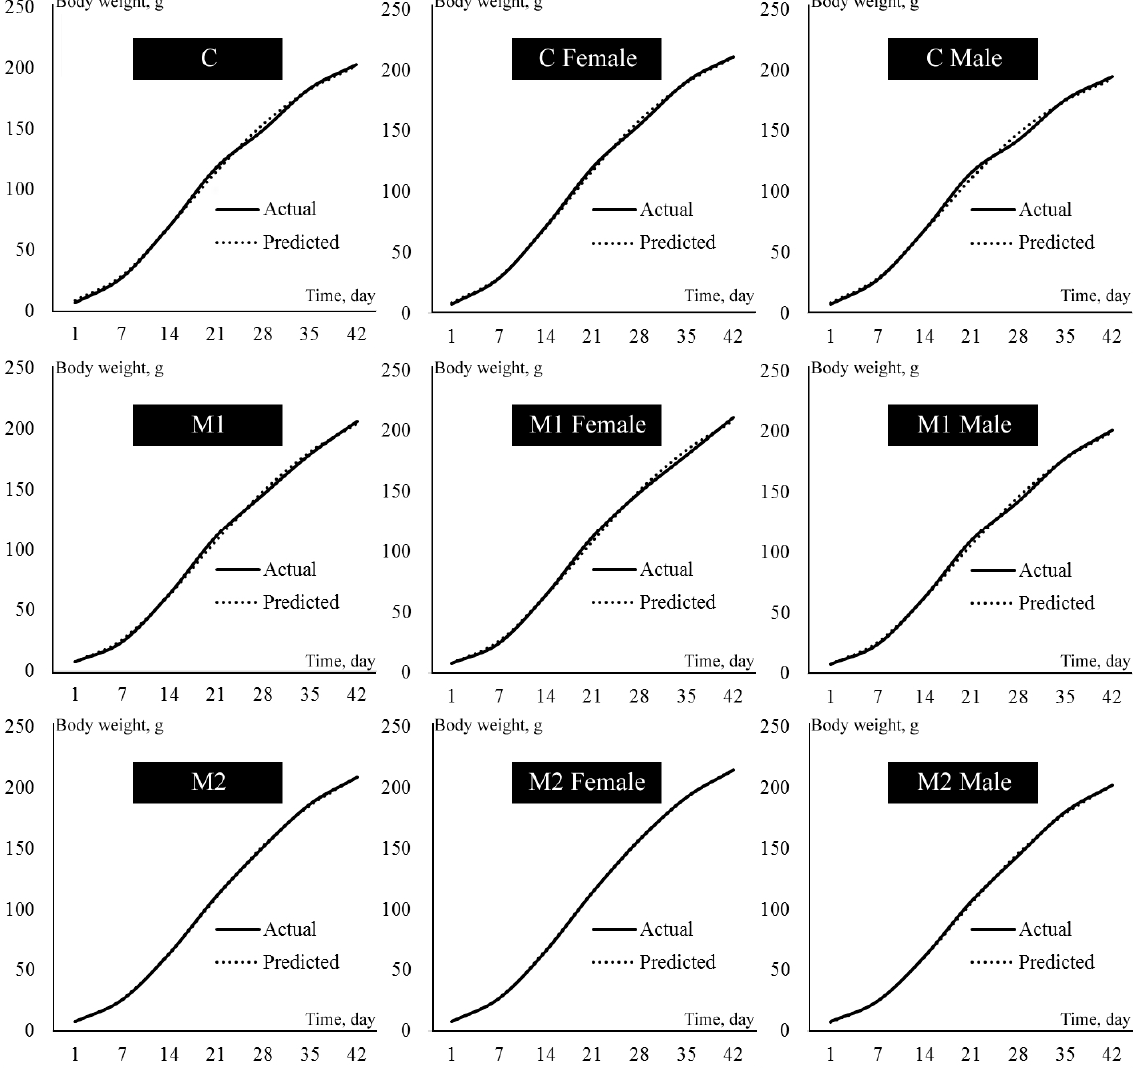
Figure 1. Actual and predicted growth curves by treatment for groups and sex.